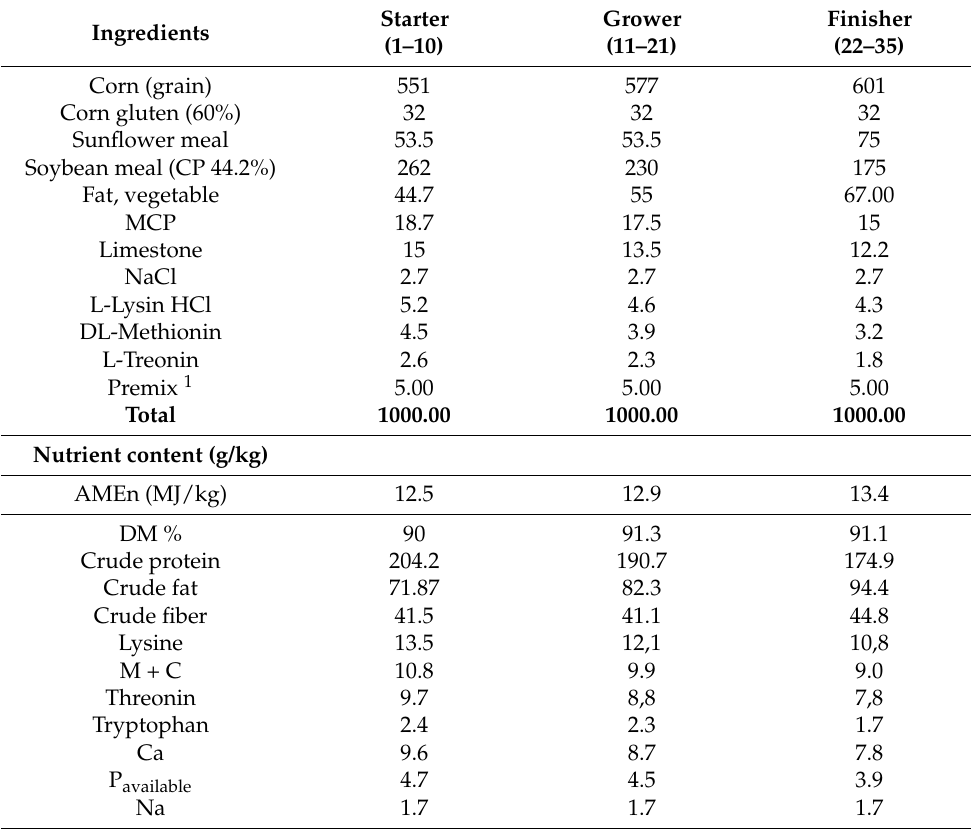
Table 3. Composition and calculated nutrient content of the basal diets